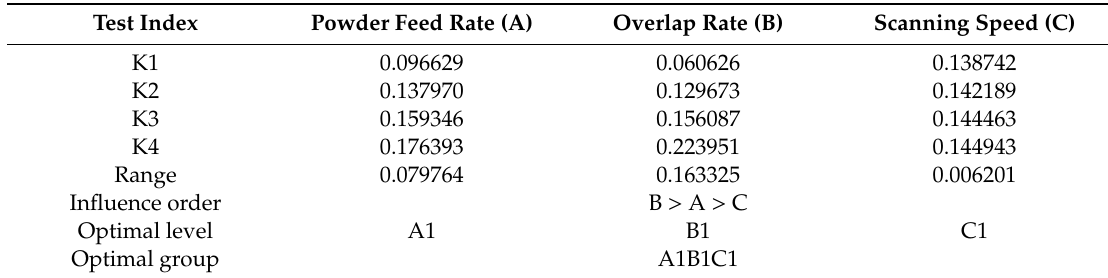
Table 5. Range analysis.